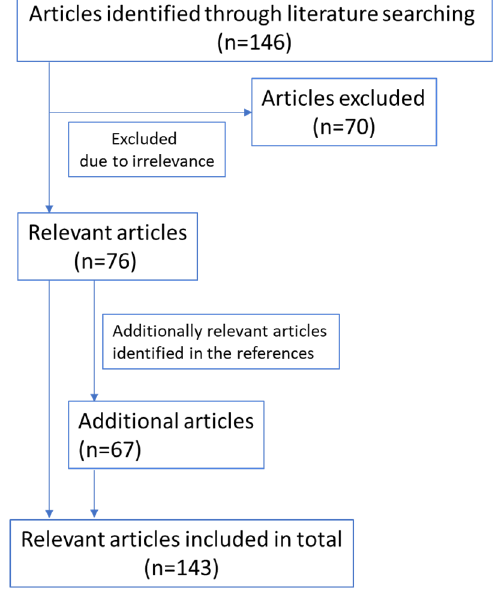
Figure 1. Relevant references